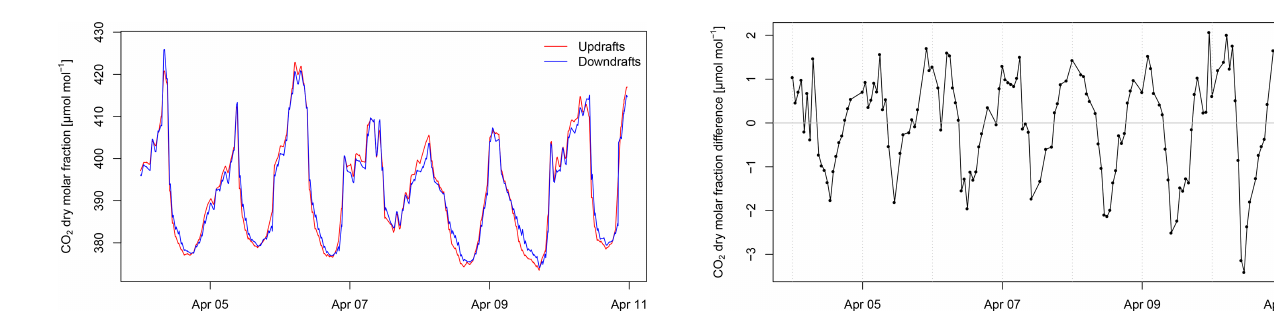
and 10 April 2015, Fig.